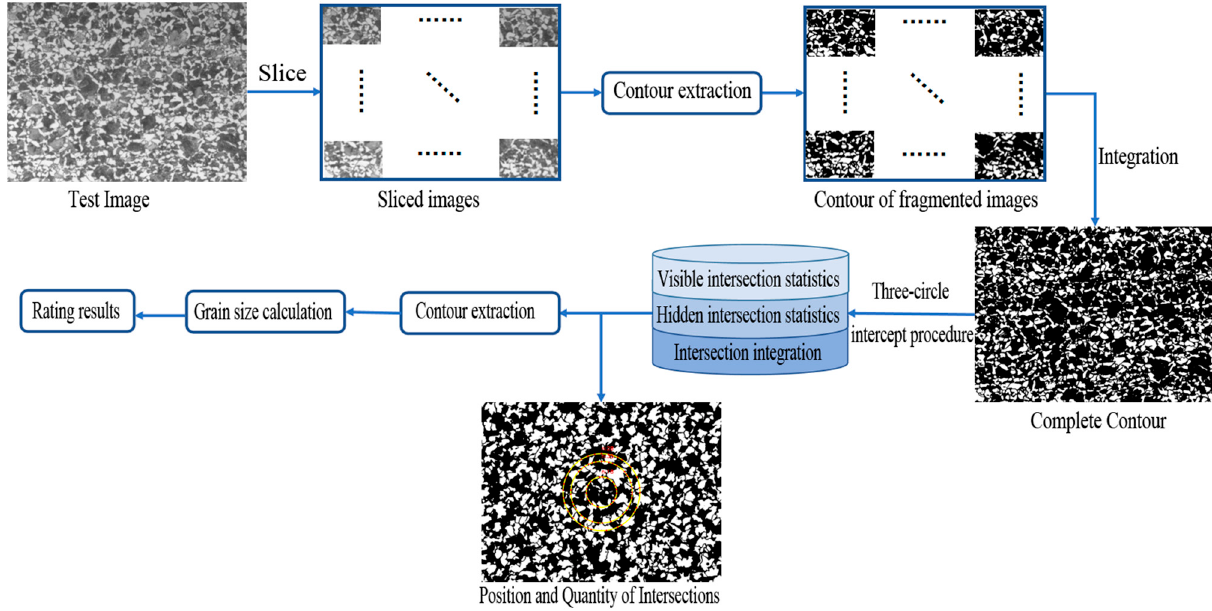
Figure 9. Model architecture.